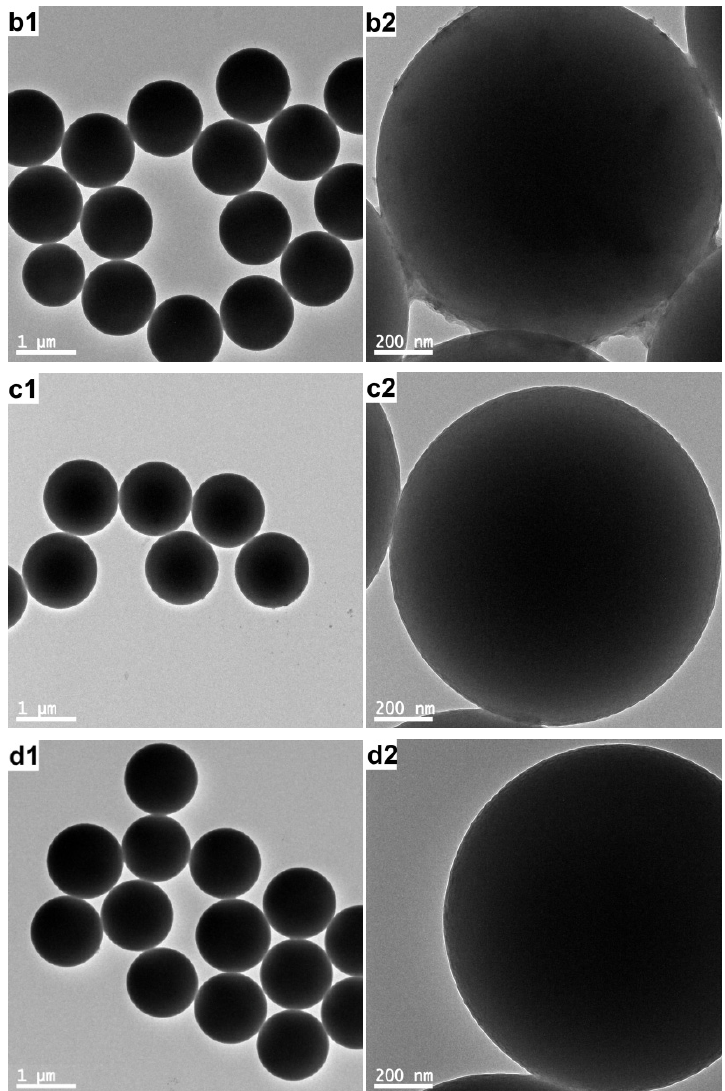
Figure 5. TEM images of the products prepared with a fixed amount of PS (0.4 g), and varied AT amounts at various magnifications: ( a ) 0.4 g (run 1); ( b ) 0.3 g (run 2), ( c ) 0.2 g (run 3); and ( d ) 0.1 g (run 4).